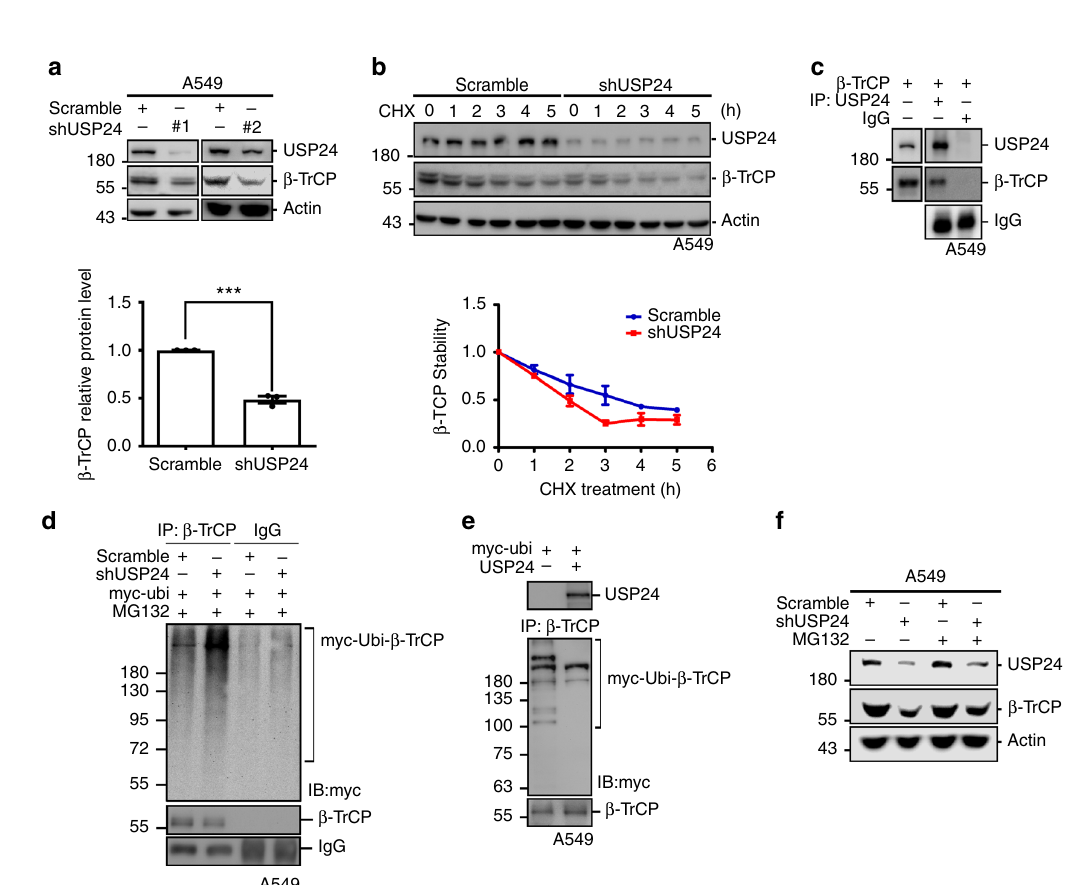
Fig. 6 USP24 stabilizes β -TrCP in A549 cells. a Western blotting was used to analyze β -TrCP level in scramble knockdown and USP24 knockdown A549 cells by using two different shRNA clones ( n = 3). b Scramble- and USP24-knockdown A549 cells were treated with CHX and β -TrCP protein stability was analyzed by western blotting ( n = 3). c β -TrCP overexpressed A549 cells were collected for immunoprecipitation with anti-USP24 antibody and indicated proteins were analyzed by western blotting. d Scramble-knockdown and USP24-knockdown A549 cells were overexpressed with myc-ubi and collected for immunoprecipitation with anti- β -TrCP antibody. Indicated protein was analyzed by western blotting. e A549 cells were overexpressed with myc-ubi and harvested for immunoprecipitation with anti- β -TrCP antibody. Human puri fi ed USP24 protein was mixed with IP sample and analyzed by western blotting. f Indicated protein levels of samples from scramble or USP24 knockdown A549 cells with or without MG132 treatment were analyzed by western blotting. Results of western blot were normalized with actin and expressed as fold of control. Data are shown as mean ± SEM, two-tailed unpaired Student ’ s t -test, *** P <